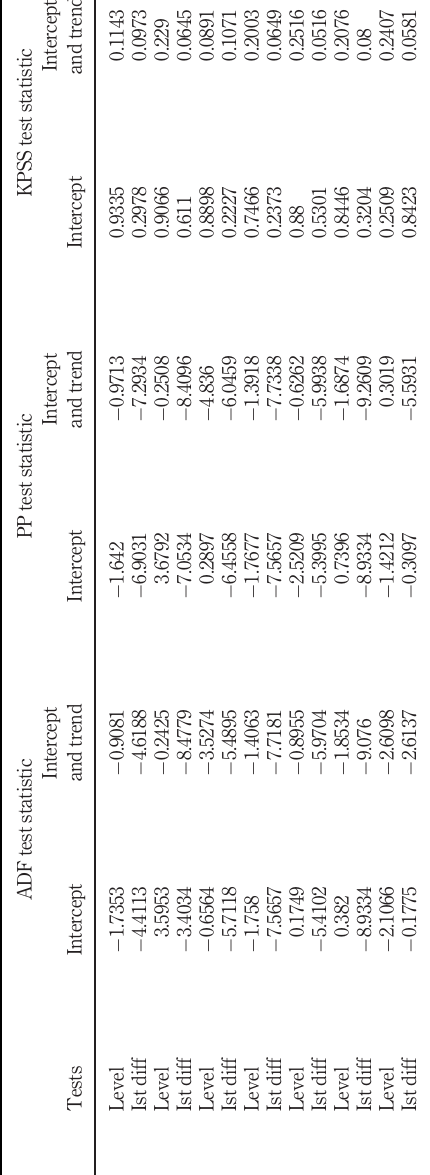
Table 2. Result of unit root